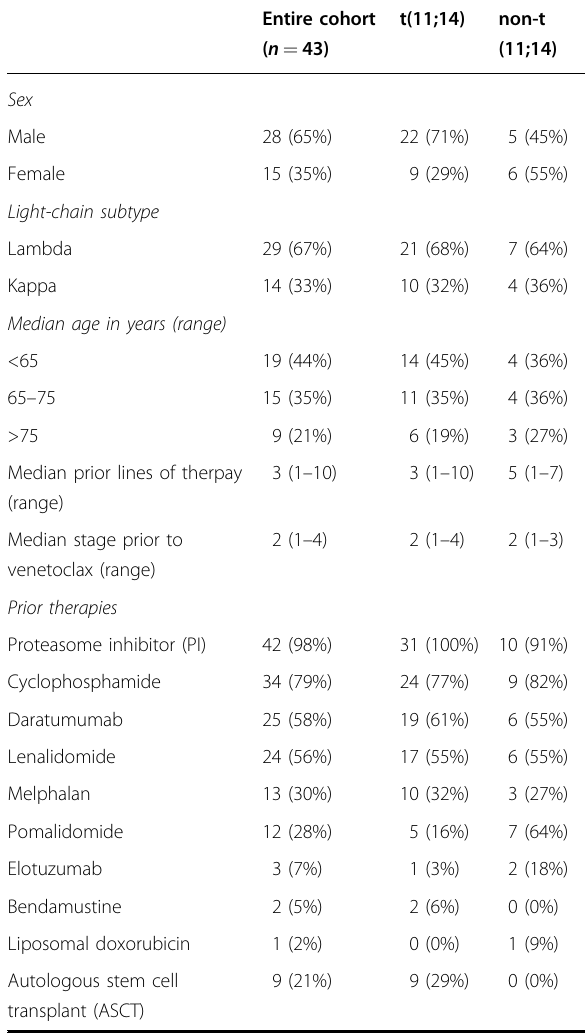
Table 1 Patient demographics and